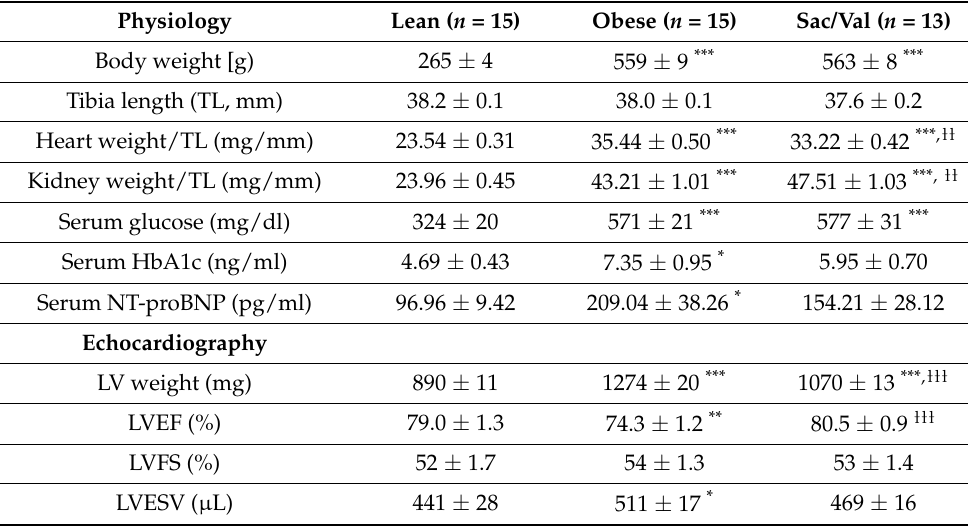
Table 2. Characterization of the 32-week-old lean and obese